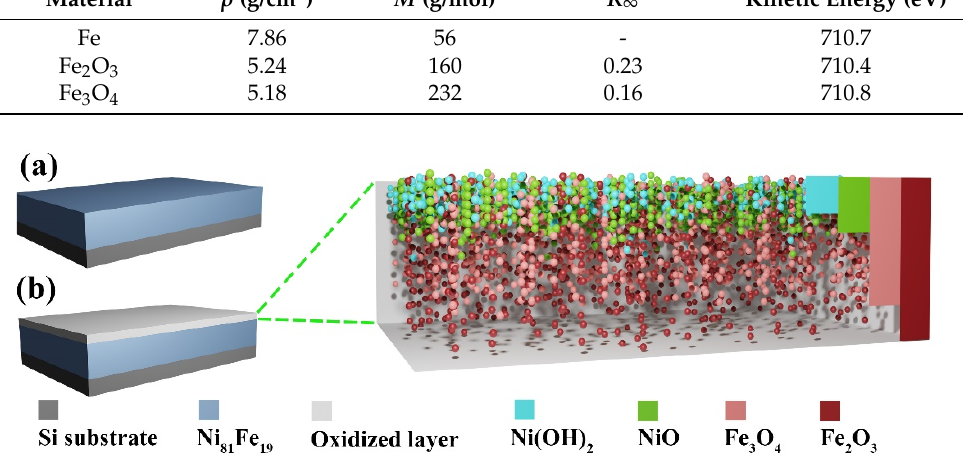
Figure 10. The schematic diagram of NiFe thin film: ( a ) unoxidized, ( b ) oxidized.